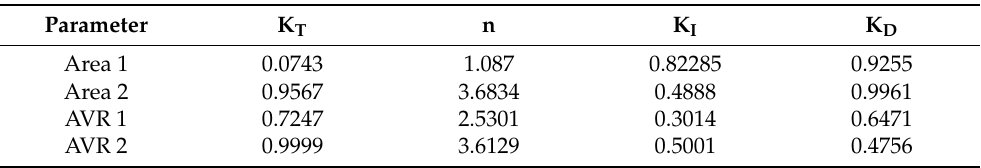
Table 20. TID parameters for the combined AGC and AVR system with RLD, all non-linearities, and a 0.2 s delay.